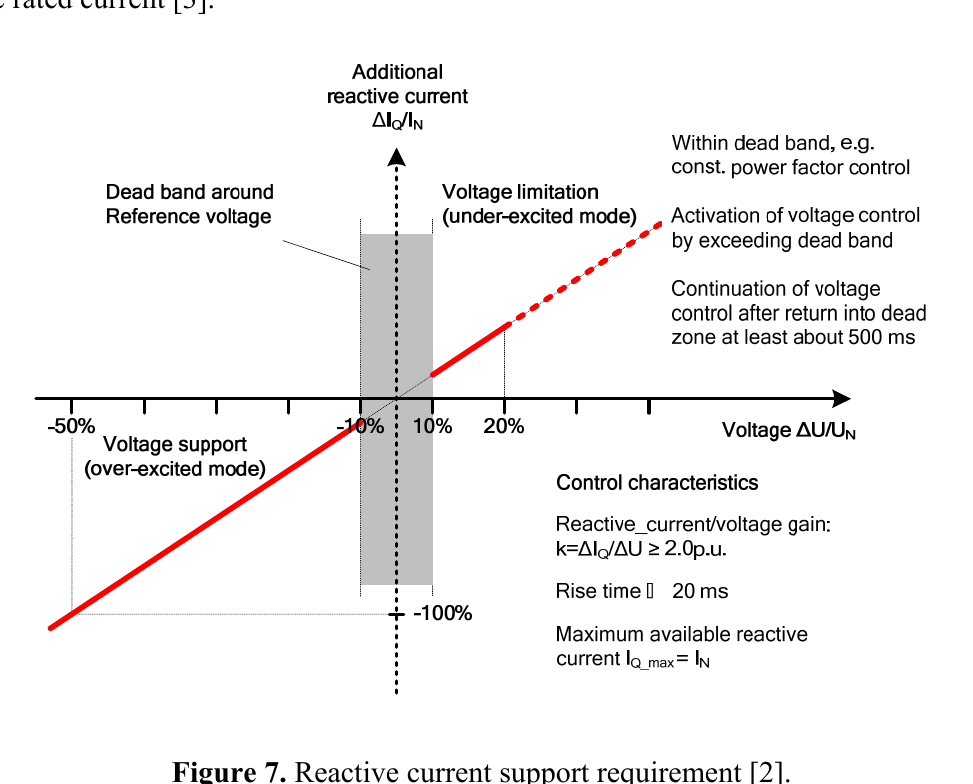
Figure 7. Reactive current support requirement